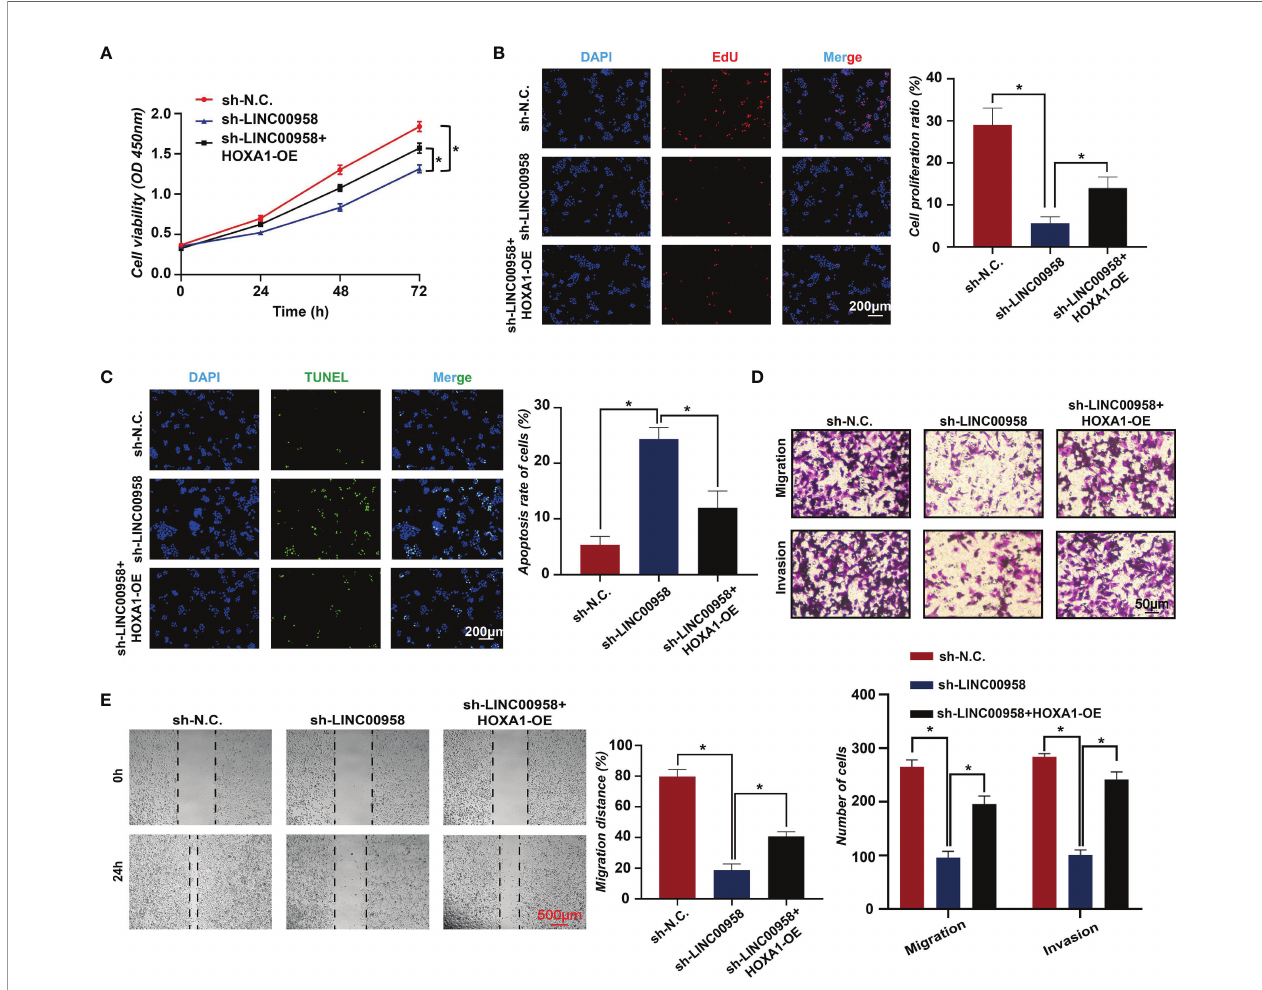
FIGURE 7 | HOXA1 overexpression partially mitigates the oncogenic function of LINC00958. (A) Cell counting kit-8 assay results of LINC00958 knockdown, HOXA1-overexpressing LINC00958 knockdown, and control A549 cells at 0, 24, 48, and 72 h. (B) The proliferation of LINC00958 knockdown, HOXA1- overexpressing LINC00958 knockdown, and control A549 cells was examined using the 5-ethynyl-2 ′ -deoxyuridine incorporation assay. (C) Terminal deoxynucleotidyl transferase biotin-dUTP nick end labeling assay was performed to examine the apoptosis rate of LINC00958 knockdown, HOXA1-overexpressing LINC00958 knockdown, and control A549 cells. (D) Transwell assay was performed to examine the invasion and migration of LINC00958 knockdown, HOXA1- overexpressing LINC00958 knockdown, and control A549 cells. (E) Wound-healing assay was performed to examine the migration rate of LINC00958 knockdown, HOXA1-overexpressing LINC00958 knockdown, and control A549 cells. All assays were repeated three times. * P <